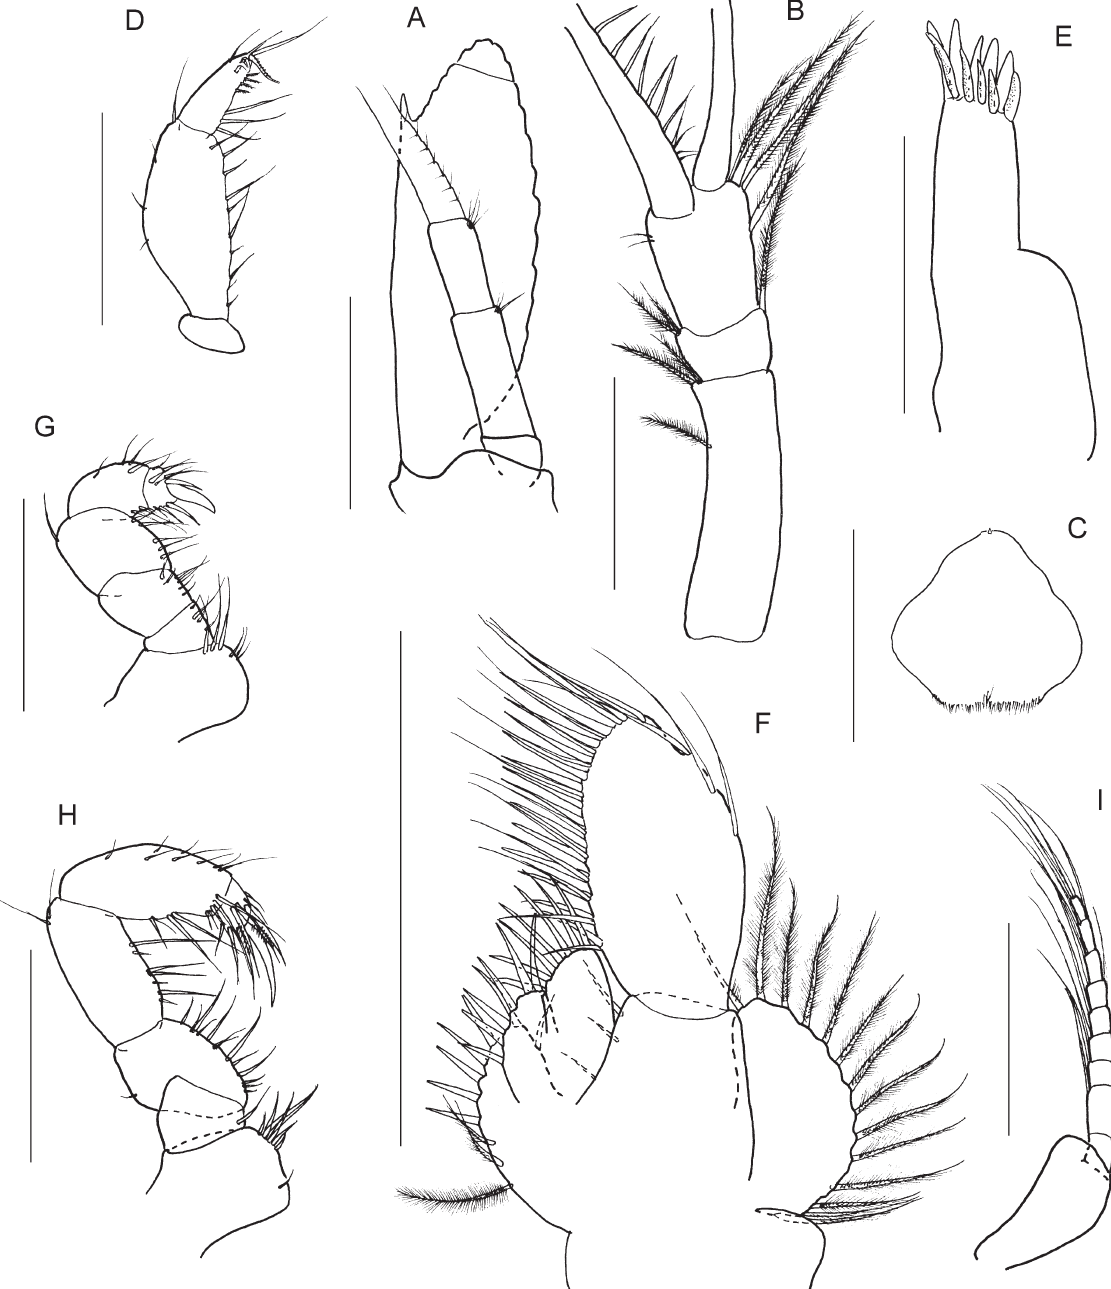
Fig. 24. Siriella tabaniocula sp. nov., holotype, ♀, length 6 mm, Ningaloo Reef, Western Australia. A . Antennal scale and peduncle of antenna 2, ventral view. B . Antenna 1, dorsal view. C . Labrum. D . Mandibular palp, lateral view. E . Maxilla 1 (endite not shown), anterior view. F . Maxilla 2, anterior view. G . Endopod of maxilliped 1, posterior view. H . Endopod of maxilliped 2, posterior view. I . Exopod of maxilliped 1. Scale bars: A–D, G–I = 0.25 mm; E–F = 0.1